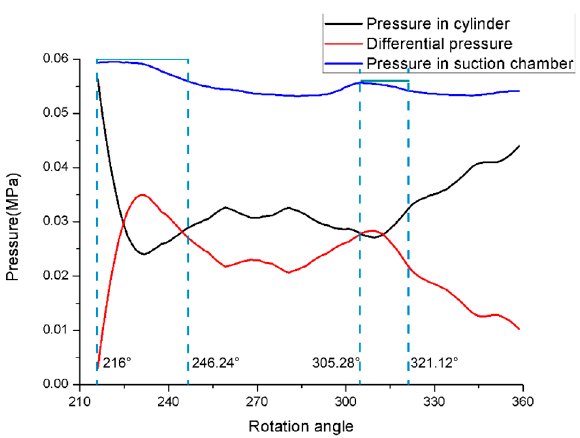
Figure 10. Suction valve displacement.